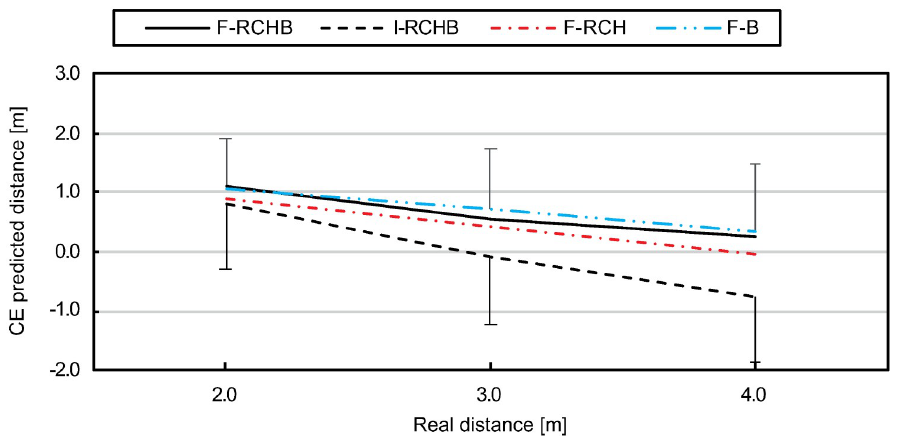
Fig 16. Constant error. Mean and standard deviation of the constant error of predicted putting distance under the I-RCHB, F-RCHB, F-RCH, and F-B conditions.